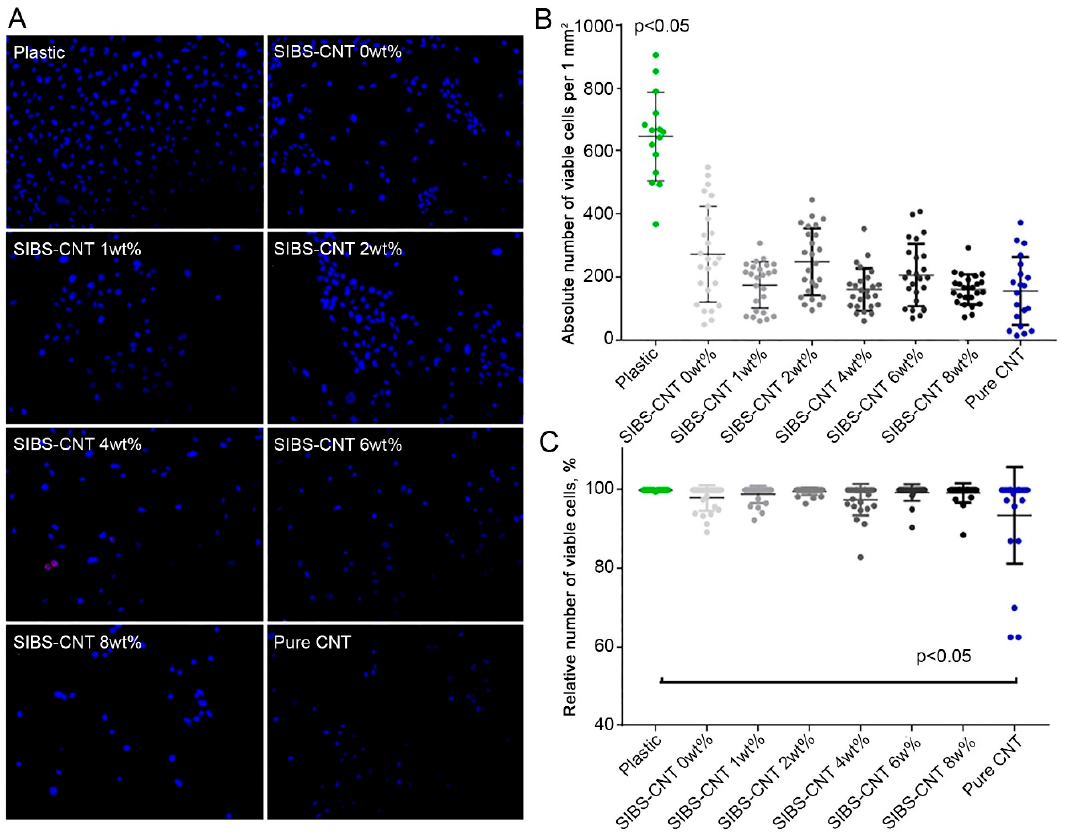
Figure 8. ( A ). Representative images of human umbilical vein endothelial cells (HUVEC) cultured on SIBS–CNT films for 3 days. Cells were stained with Hoechst (blue) and ethidium bromide (red). ( B ). The quantification of the cell number per mm 2 of SIBS–CNT surface in the indicated groups. ( C ). Percentage of the viable cells in the indicated groups.